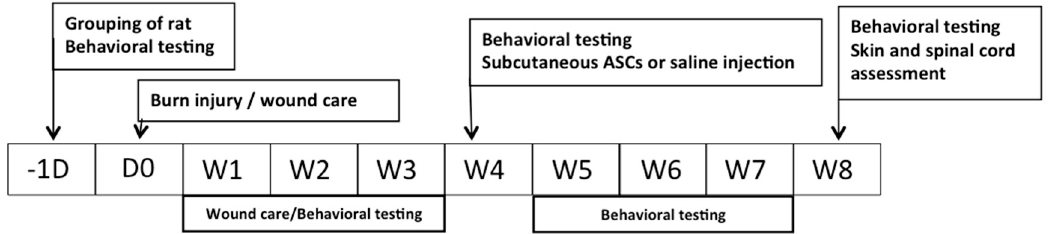
Figure 8. Flowchart of the experimental design. (D, day; W, week).